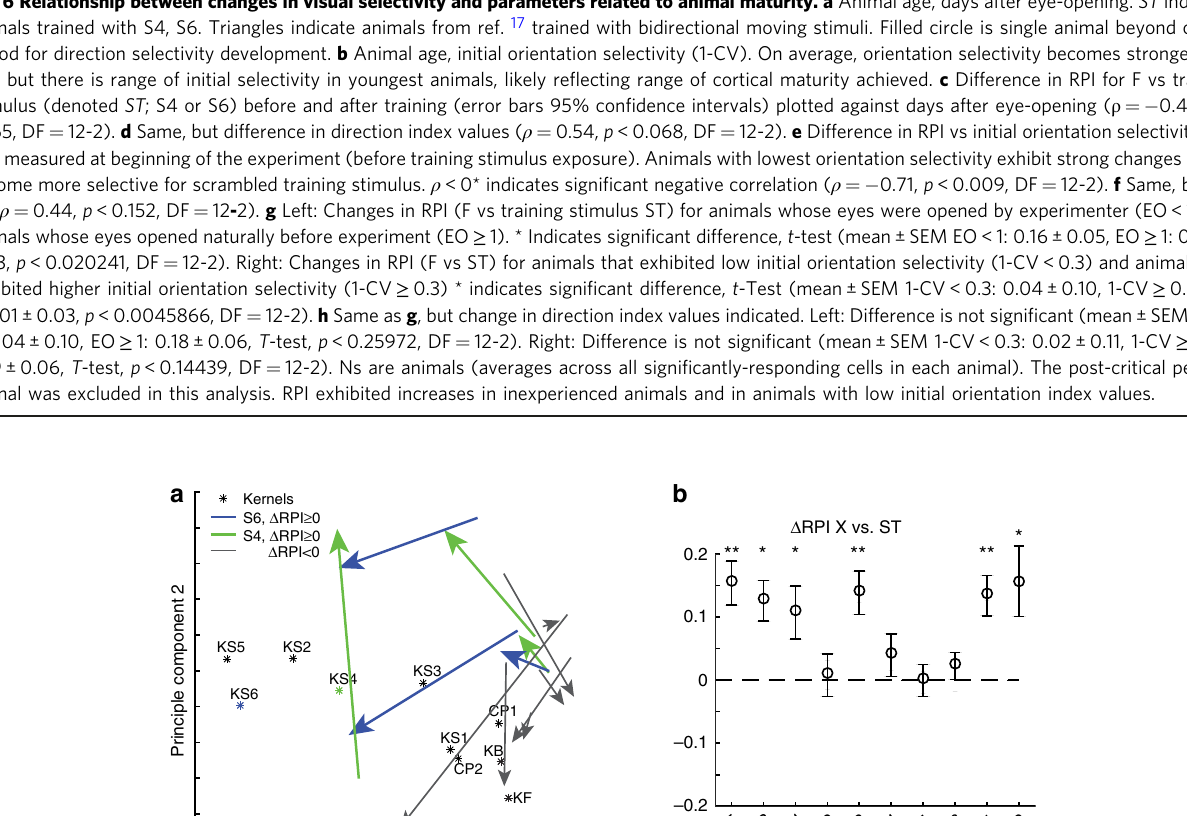
Fig. 7 Responses became more similar to those of ideal neurons selective to the training stimulus. a Principle component projection from 10- dimensional space to 2-dimensional space of mean responses (for each animal) to the chosen set of 10 stimuli, before and after training, with vectors indicating the transition from the mean response before training to after training (arrow points at mean state after training). Responses of hypothetical neurons optimized for each stimulus (KF, S4, CP2, etc.) shown. Animals that exhibited signi fi cant Δ RPI (F vs ST ) are indicated (trained with S4 green, S6 blue). In this reduced view, average responses of signi fi cant animals moved closer to KST , while animals (8/8) that exhibited no signi fi cant effect moved to be near to KF, KB, KCP1, KCP2 (typical V1 receptive fi elds). b Change in RPI for signi fi cant animals with each stimulus used as a reference with the training stimulus ( Sn vs ST ). For animals trained with S4 or S6, values of RPI (S4 vs S4) or RPI (S6 vs S6) were excluded from the average as it is 0 by de fi nition. Error bars indicate SEM of the mean. * or ** indicates one-tailed T -test (* p < 0.05, ** p < 0.005, DF = 6, DF = 3 when X is S4/S6) with mean > 0. Comparison for each RPI (X vs ST) is single comparison evaluating only stimulus X. Changes in responses became more like a hypothetical neuron tuned to the training stimulus KST than stimuli F, B, S1, S3, S4, CP1, and CP2, and changes in responses remained equally close to stimuli S2, S5, and S6 (when S6 was not the training stimulus) on average. As responses changed in 10-dimensional space, they moved closer to KST for most stimuli while moving no closer or farther from KS2, KS5, and KS6. This is consistent with the idea that the training stimulus provided an instructive in fl uence on receptive fi eld properties in this early developmental